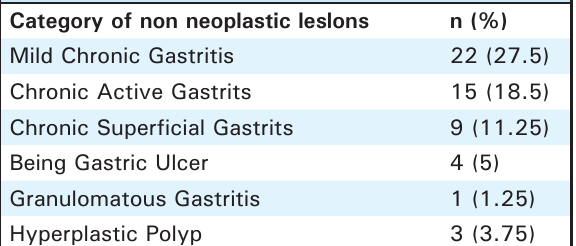
Table 1. Distribution of cases on the basis of mor-